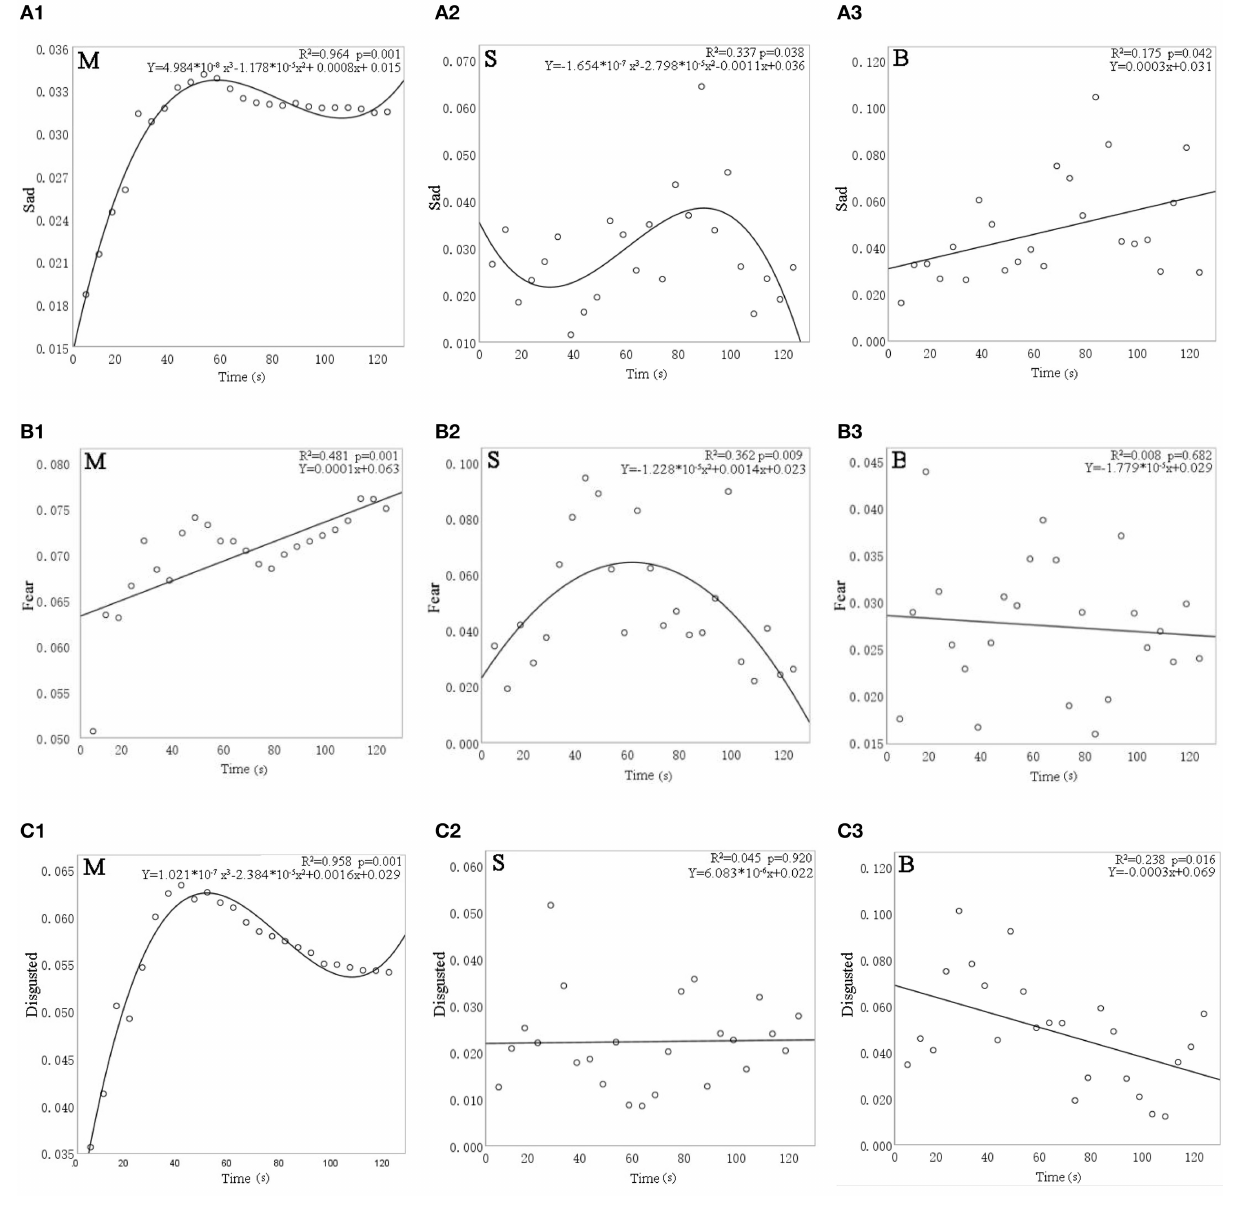
significantly lower than that in the normal group (mean = 0.060, SD = 0.071), most substantially at 80